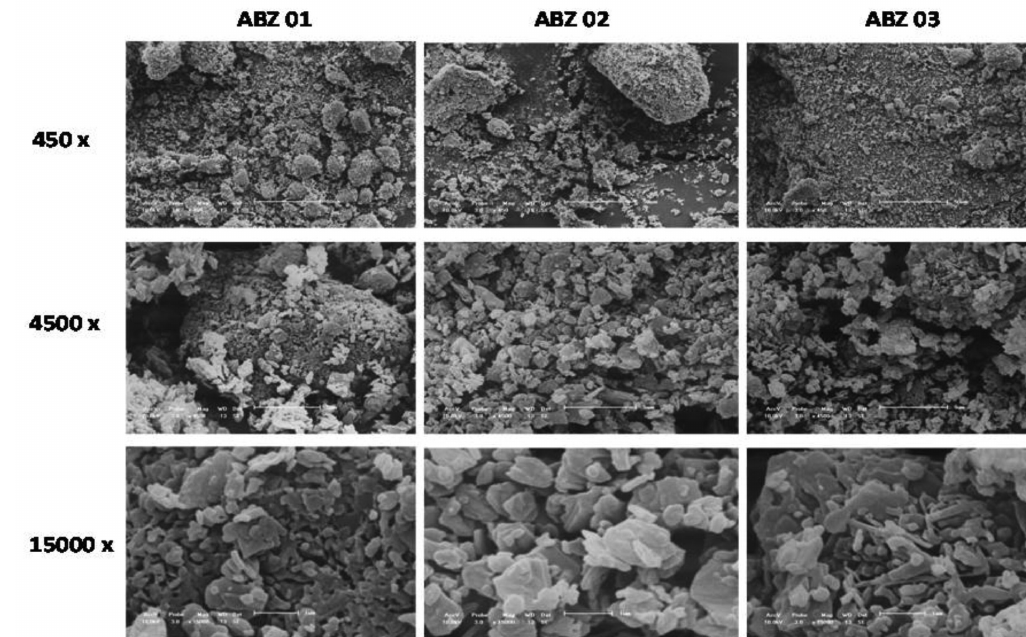
FIGURE 6 - Crystal morphologies of ABZ01, ABZ02, and